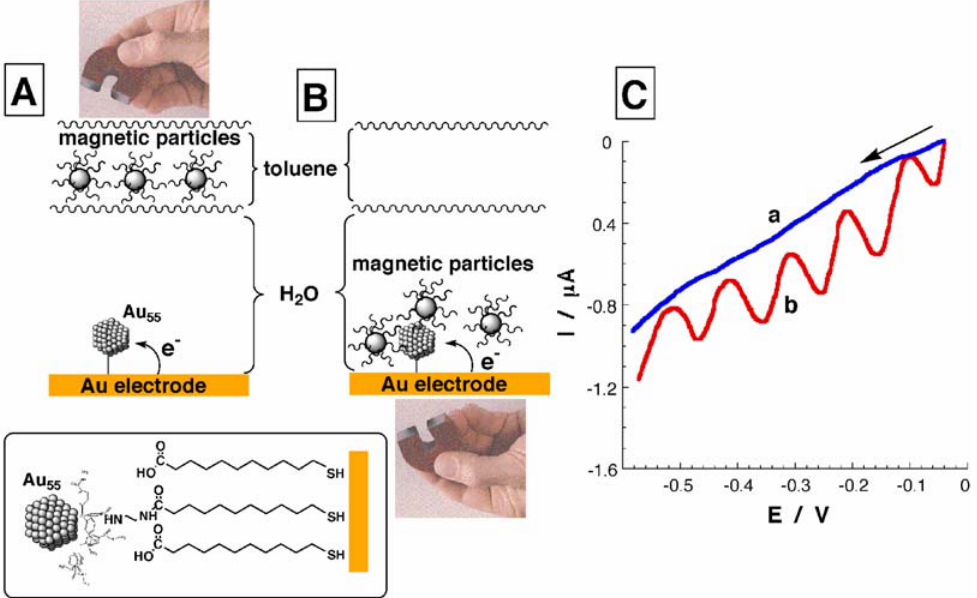
Figure 2. Magneto-controlled quantum charging of the Au NPs associated with a Au electrode in the presence of hydrophobic magnetic NPs and two-phase liquid solution: (A) Magnetic NPs are retracted from the electrode surface. (B) Magnetic NPs are attracted to the electrode surface. (C) Linear sweep